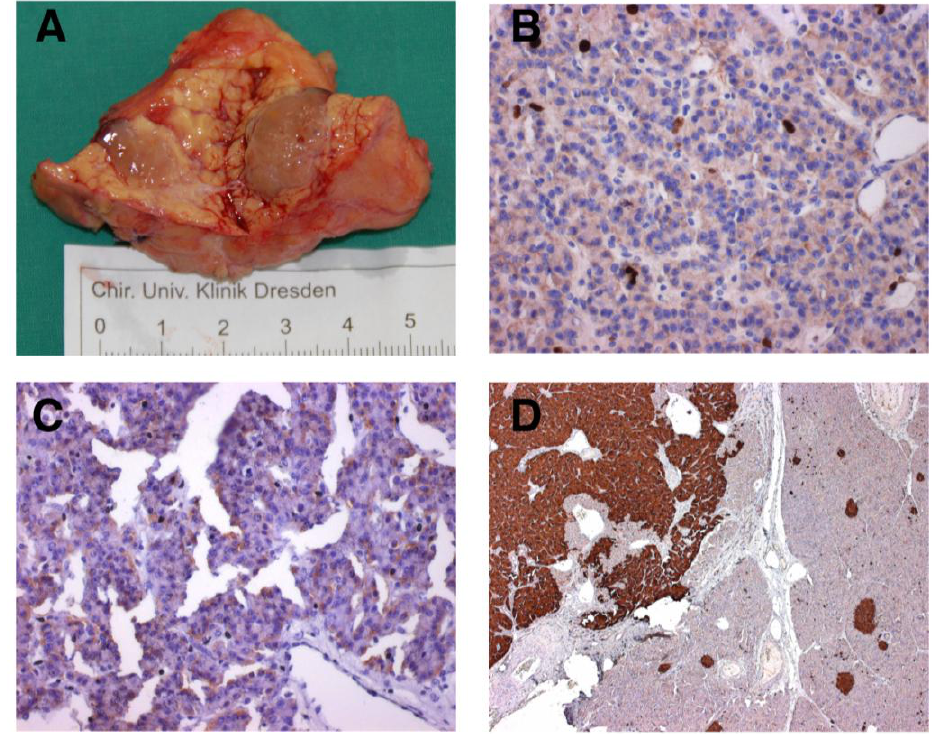
Figure 1. ( A ) Enucleated pancreatic insulinoma; ( B ) immunostaining of the